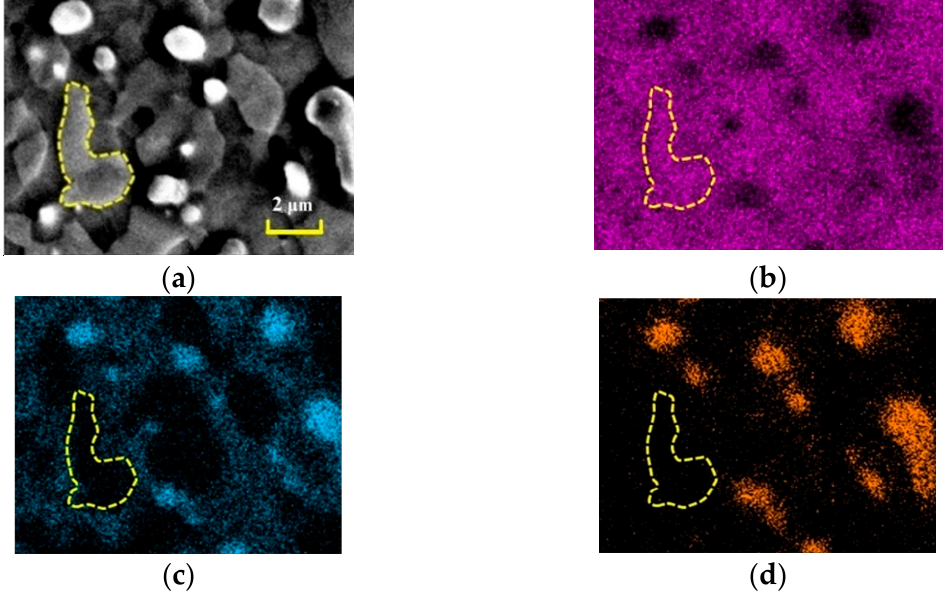
Figure 3. Element distribution map of substrate region. ( a ) SEM micrograph; ( b ) Mo; ( c ) Si; ( d ) B.